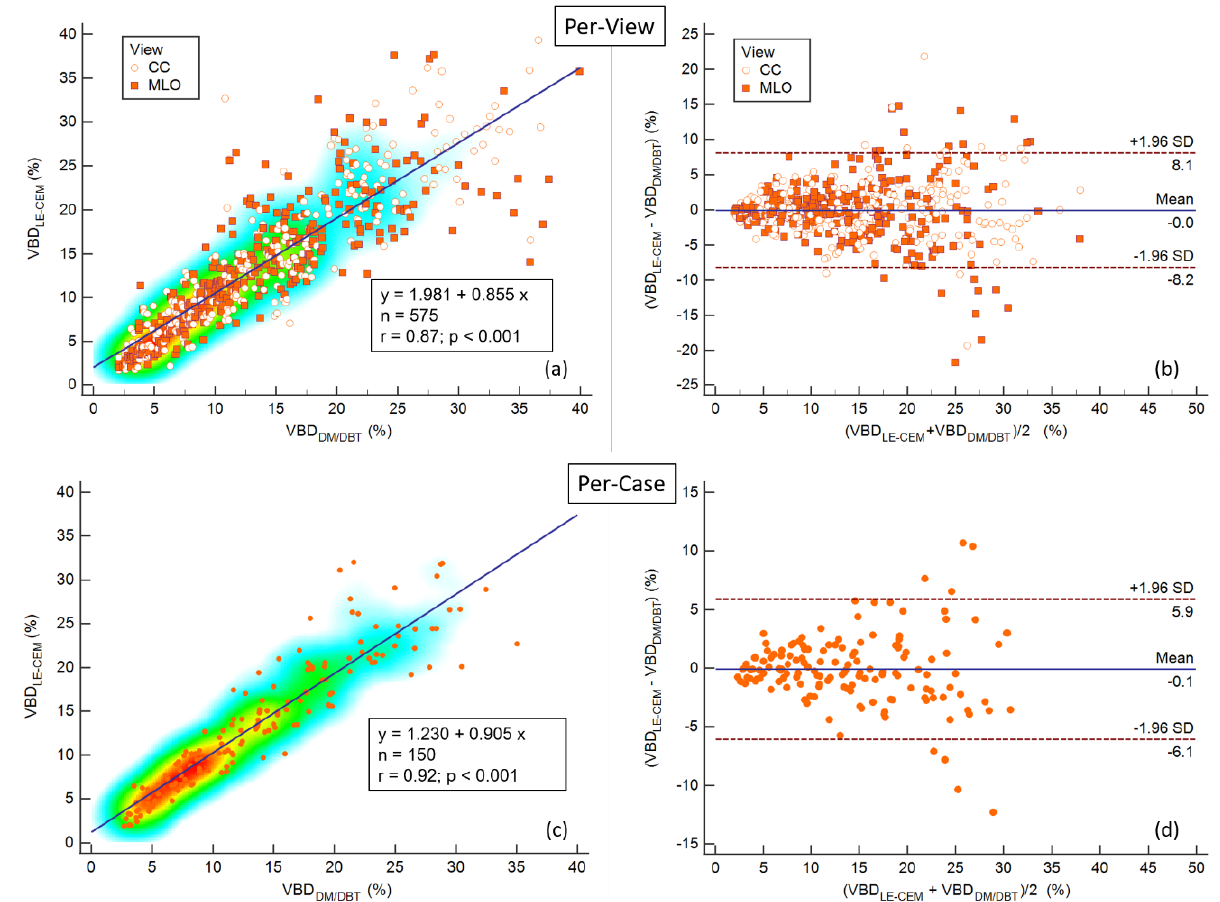
Figure 1. ( a ) Correlation plot of VBD measured in paired views obtained from LE-CESM and previous/subsequent DM/DBT exams; the Pearson’s correlation coefficient was r = 0.87, a reduction in correlation can be observed as VBD increases, especially for MLO views. ( b ) Bland–Altman plot of VBD differences between LE-CESM and previous/subsequent DM/DBT for each paired view; the mean difference was zero, the limits of agreement were ± 8%. ( c ) Correlation plot of mean VBD obtained by averaging single-view VBDs for each paired study obtained with LE-CESM and DM/DBT; the Pearson’s correlation coefficient was r = 0.92, the heat map shows that VBD values were mostly grouped below 15%. ( d ) Bland–Altman plot of VBD differences between LE-CESM and previous/subsequent DM/DBT for each paired study; the mean difference was confirmed to be very close to zero, and the limits of agreement were reduced to ±5%.